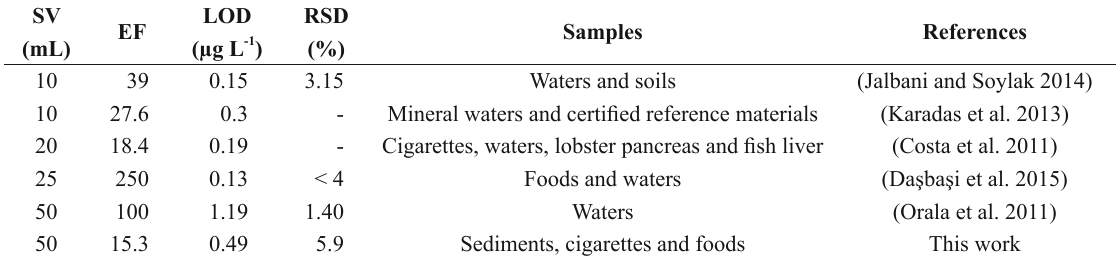
Comparison among the performance of the proposed method and some methods from literature that also use solid- phase extraction for cadmium determination by FAAS.